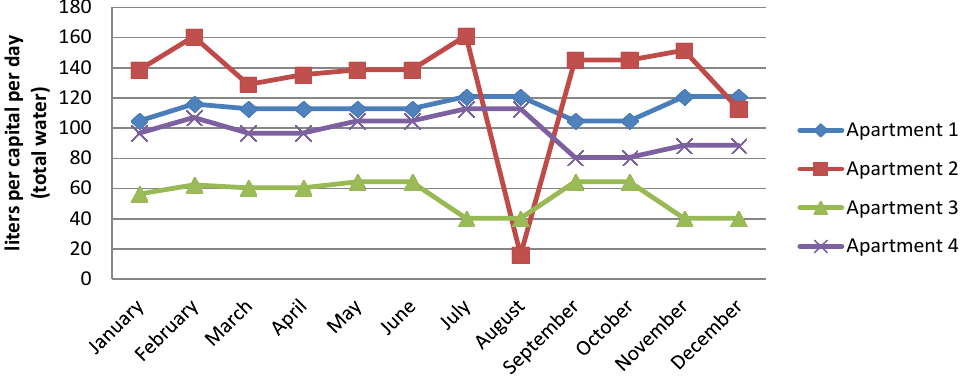
Figure 2. Variation of water consumption per tenant throughout the